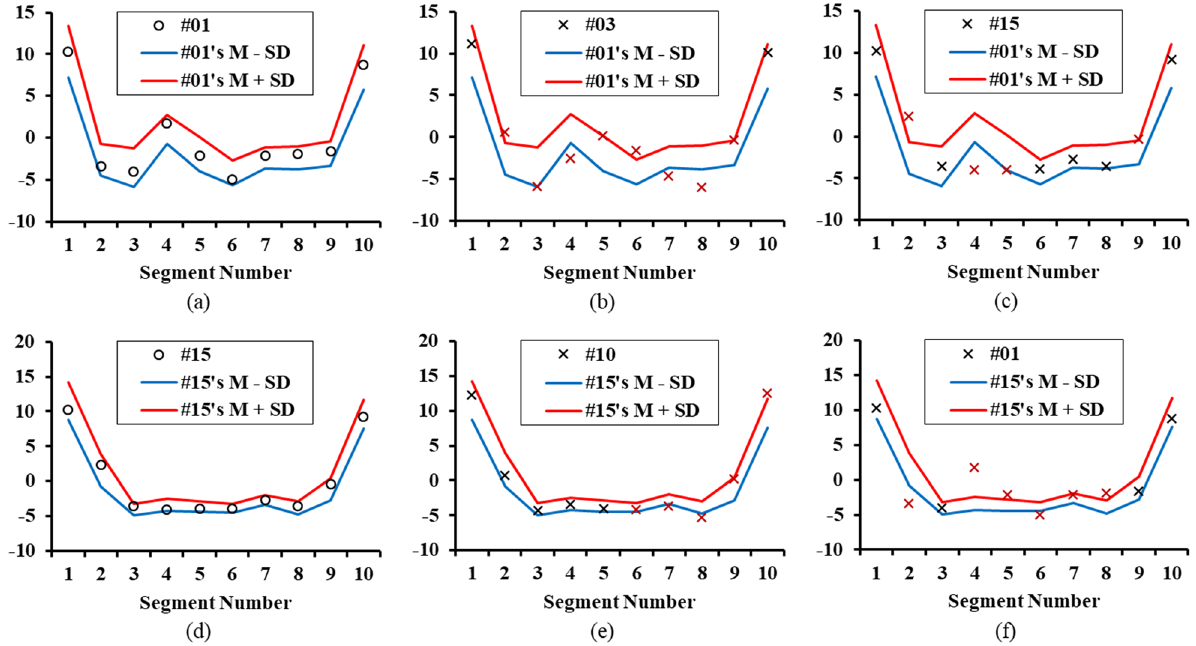
Figure 1. Examples of individual identification; ( a ) when the normalized data of subject #1 in Group 1 was compared with subject #1’s reference data, ( b ) when subject #3’s data in Group 1 was compared with subject #1’s reference data, ( c ) when subject #15’s data in Group 2 was compared with subject #1’s reference data, ( d ) when subject #15’s data was compared with subject #15’s reference data, ( e ) when subject #10’s data in Group 2 was compared with subject #15’s reference data, and ( f ) when subject #1’s data in Group 1 was compared with subject #15’s reference